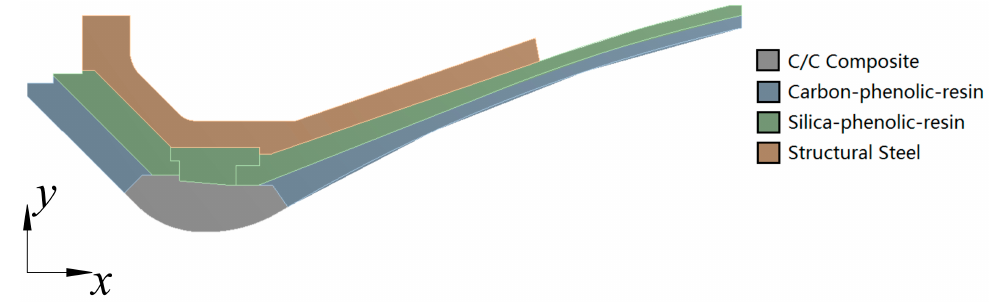
Figure 1. Sketch of the chosen nozzle. Table 1. Nozzle Dimensions.